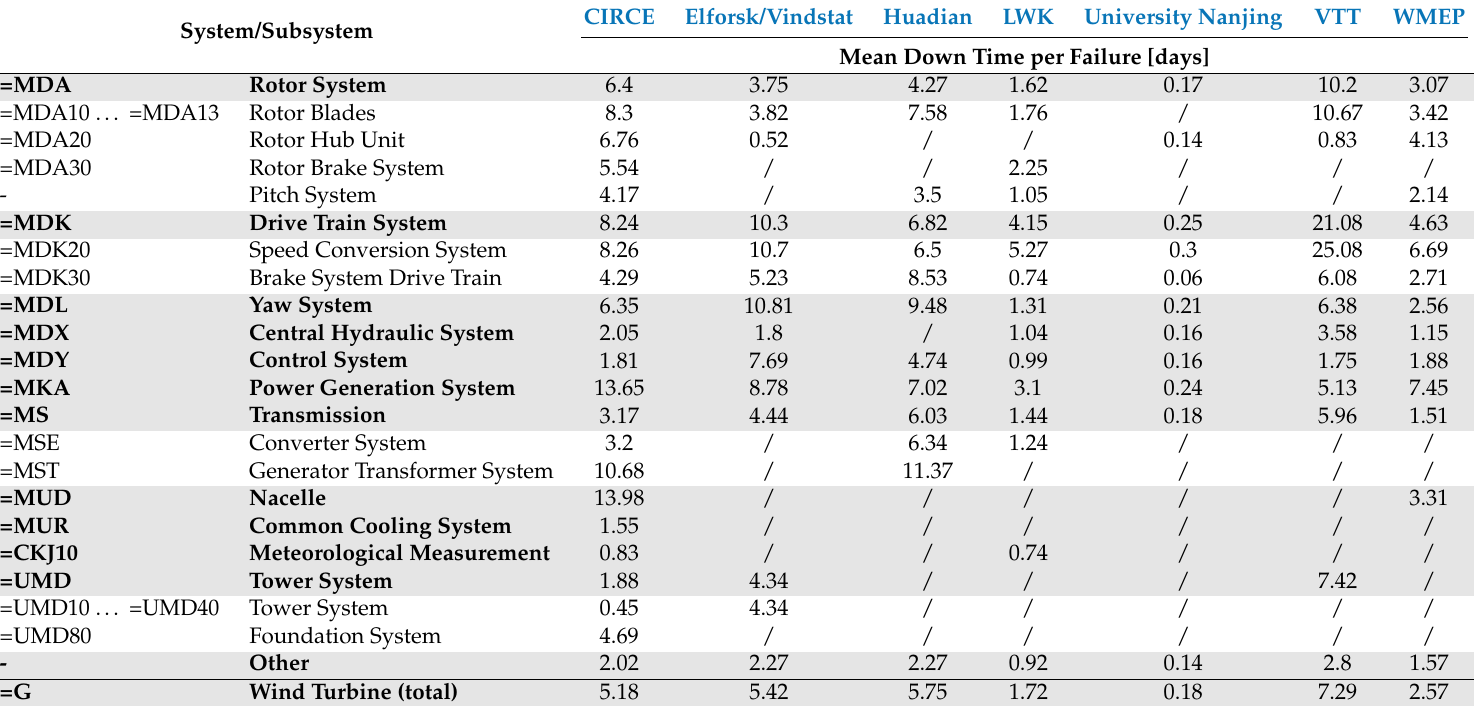
Table 6. Mean down time per failure of onshore WT as published by different